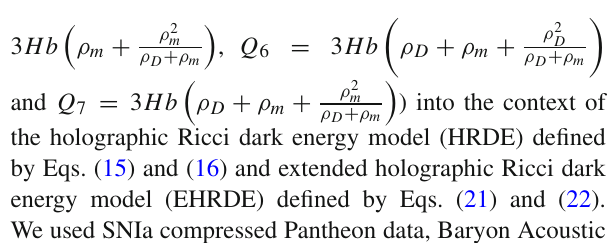
is the nuisance parameter of SNIa data, b fgas is the nuisance parameter of fgas mass fraction data, z t is the transition redshift and Age is the age of the Universe for the HRDE model. The best-fitted values of these parameters are listed in Table 2